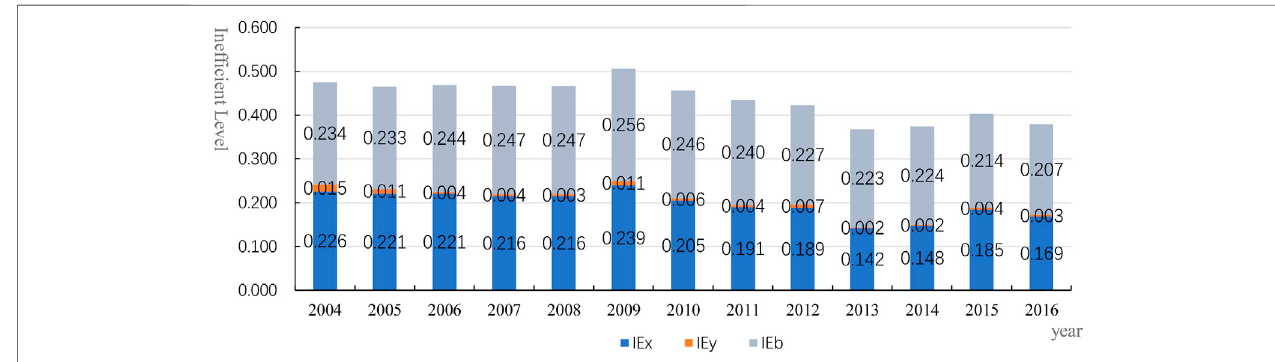
FIGURE 1 | Inef fi ciency levels in fourth case (K/L/S/E) when the capital, labor, land and energy elements are all